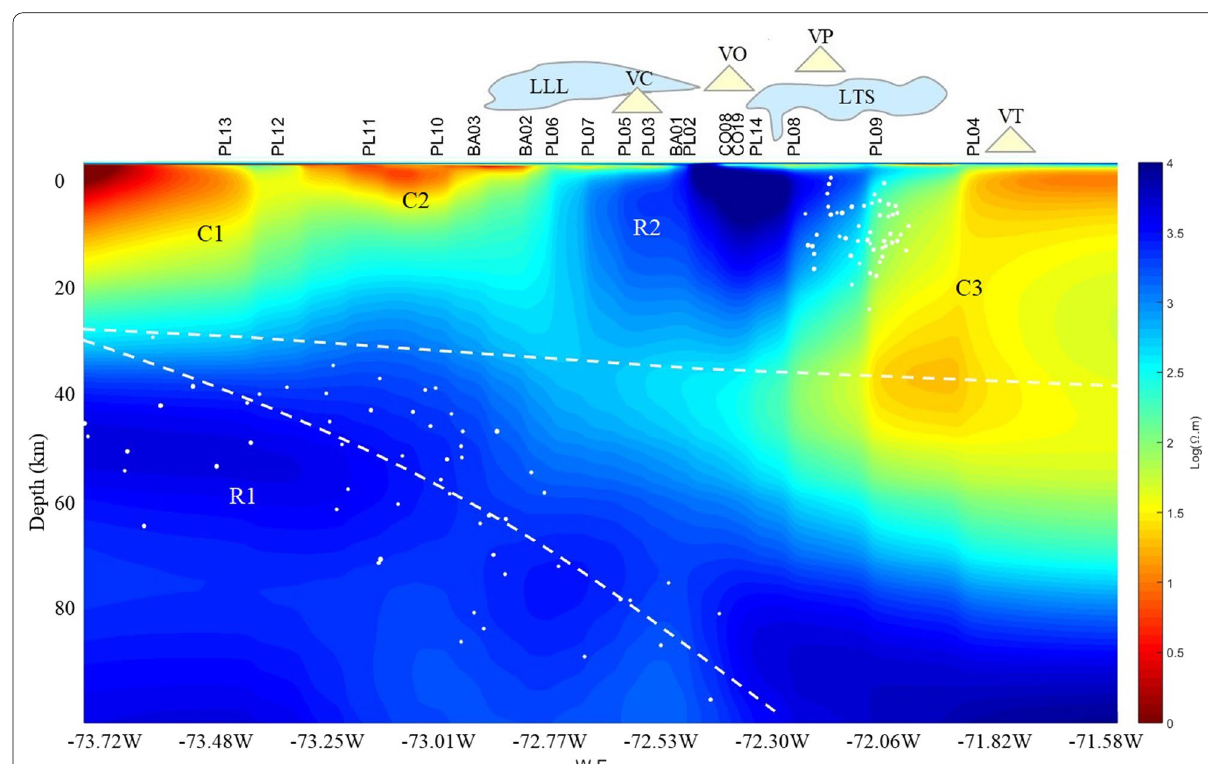
Fig. 4 Final two-dimensional model RMS 1.88%. With the local geology of reference, Lago Llanquihue (L.LL), Lago de Todos Los Santos (L.TS), Calbuco (VC), Osorno (VO), Tronador (VT) and Puntiagudo (VP) volcanoes; the white circles correspond to the seismicity of the zone recorded among the 39. 5° and 41.5° S by the Chilean CSN. The white dashed line (approx. 25 km depth) corresponds to the Moho discontinuity, taken from the Crust1.0 model by Laske et al. (2013). The white dashed line lower refers to the Slab1.0 (Hayes et al. 2012). “C" bodies correspond to conductive structures while "R" bodies correspond to resistive